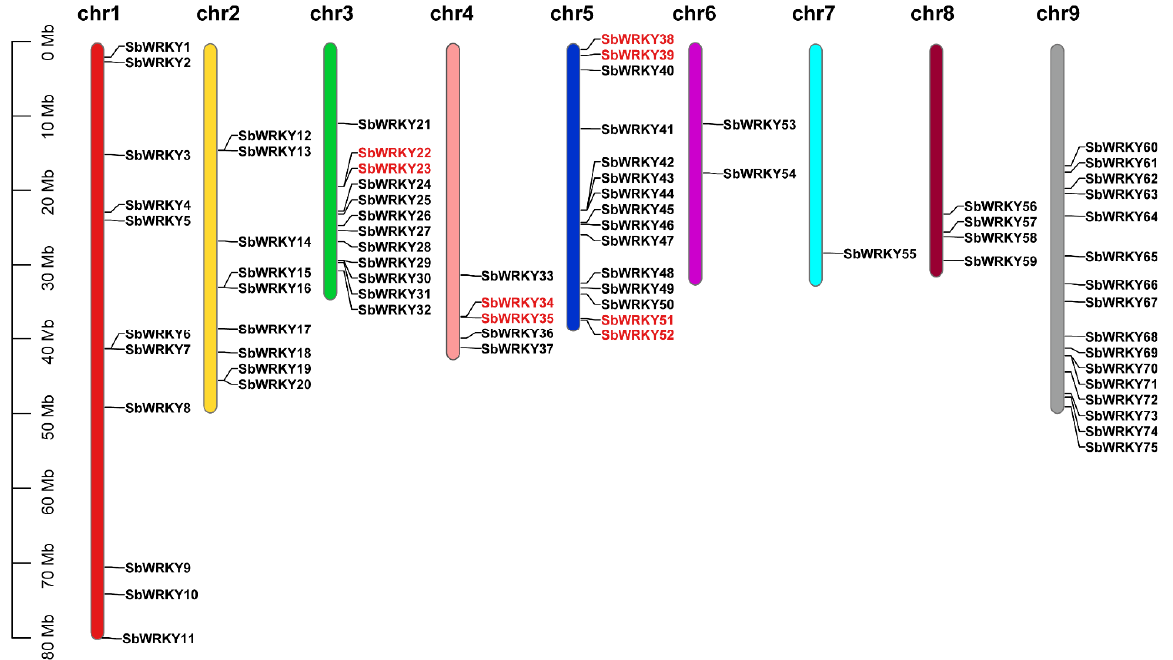
Figure 1. Chromosomal distribution of SbWRKY genes. The position of every SbWRKY gene can be determined using the left scale. Chr1–Chr9 above the colored bars indicates chromosome (Chr) numbers. The physical location of each SbWRKYs is shown, and the gene name is indicated on the right side of each bar as SbWRKY# and the red font indicate tandem duplications.